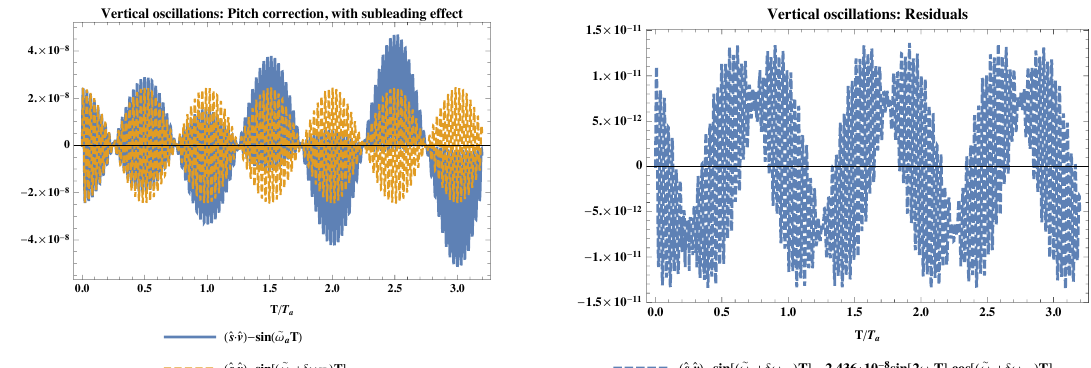
Figure 2 . We have solved numerically the equations of motion and then evaluated ^ s (cid:1) ^ v = ((cid:6) (cid:1) v ) = ( (cid:13) j v jj S j ) on the solution. The left plot shows that a better (cid:12)t is achieved by adding the subleading correction (cid:14)! SL of eq. (6.14) to the traditional \pitch correction", contained in ~ ! a . Here T a (cid:17) 2 (cid:25)=! a . The residual is well (cid:12)t (right plot) by the functional form (cid:15) sin(2 ! z T ) cos((~ ! a + (cid:14)! SL )), with (cid:15) = 2 : 436 (cid:2) 10 (cid:0) 8